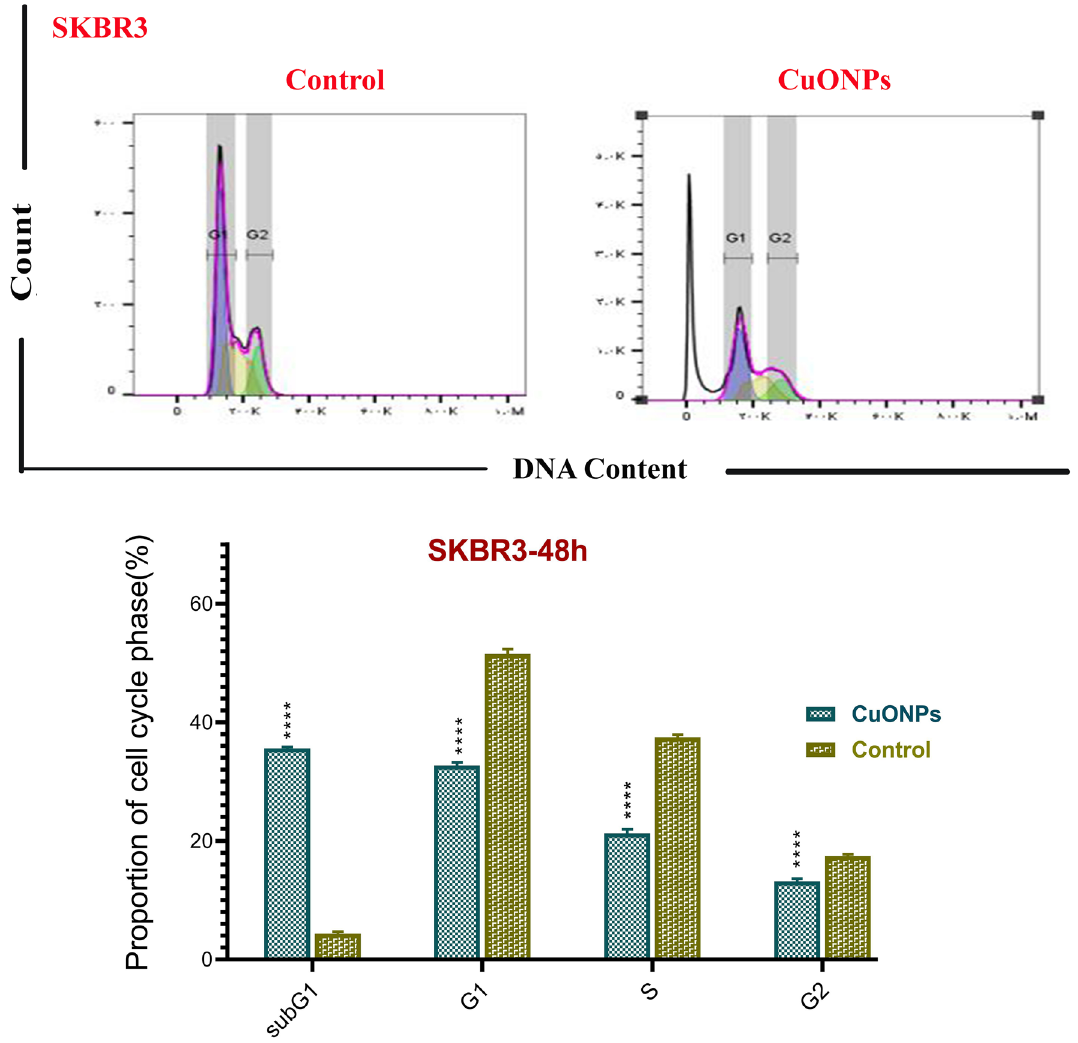
Figure 10. Cell cycle arrest in SKBR3 cells treated with IC 50 concentrations of BC-CuONPs. Comparison of cell cycle arrest of different phases in SKBR3 cells treated with IC 50 concentrations of BC-CuONPs after 48 h treatment. ****: P <